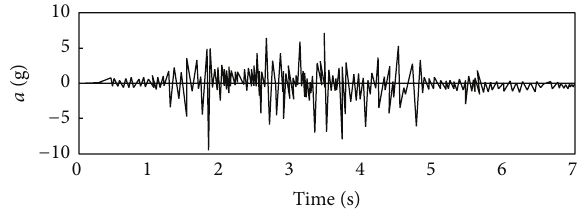
Figure 1: Measured rail vertical acceleration time history